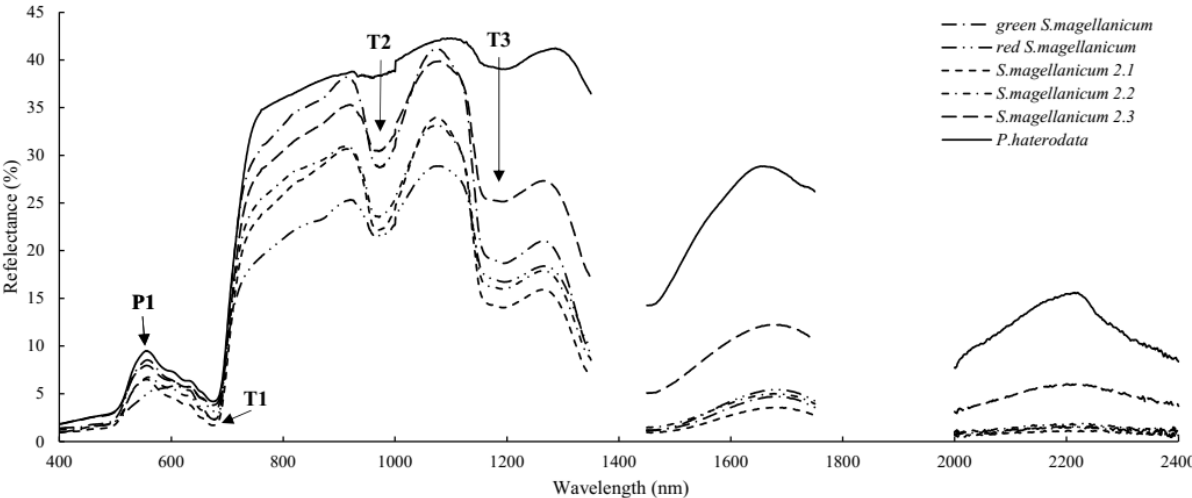
Figure 7. Spectral reflectances of P. heteroclada and S. magellanicum measured in Plots 1 and 2. P1 indicates a reflectance peak at ~550 nm; T1, T2 and T2 indicate reflectance troughs at ~600 nm, ~980 nm and ~1150 nm. Note that the spectra collected for S. magellanicum scenes in Plot 2 are labelled as S. magellanicum 2.1, 2.2 and 2.3.